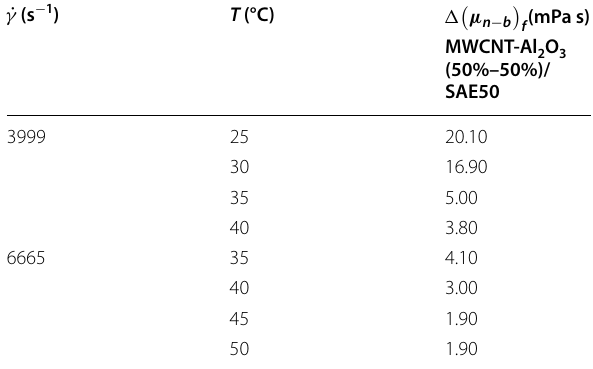
Table 6 A comparative study of the effect of temperature on the µ nf relative to the base fluid ˙ γ (s − 1 )